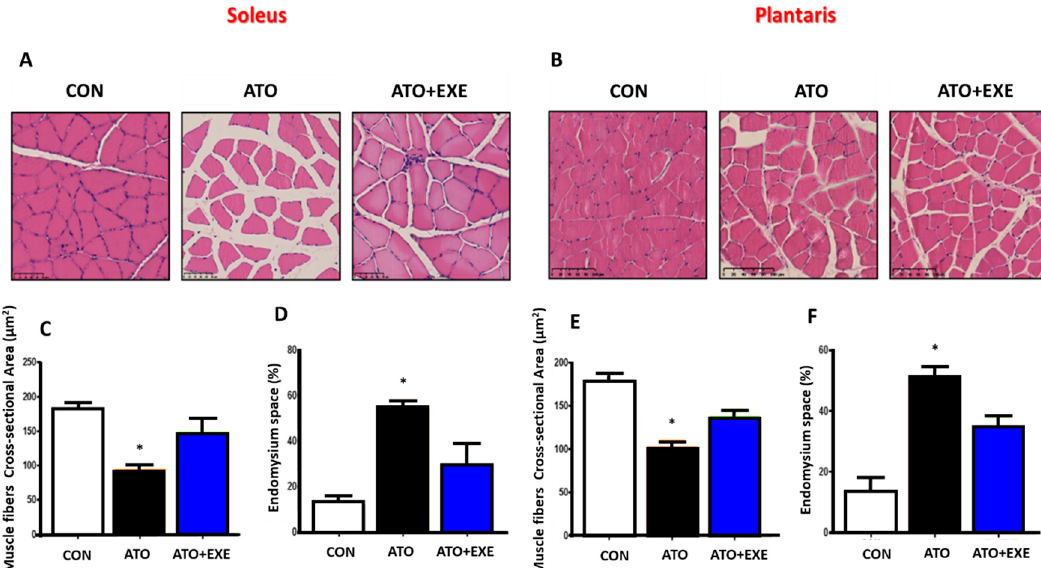
Figure 2. Atorvastatin induces skeletal muscle atrophy. Representative hematoxylin-eosin stained soleus ( A ) and plantaris ( B ) from rats; muscle fiber cross-sectional area in soleus ( C ); endomysium space in soleus ( D ); muscle fiber cross-section area in plantaris ( E ); endomysium space in plantaris ( F ). Scale bars, 100 µ m. Data are presented as means ± SEM. * p < 0.05 vs. CON.